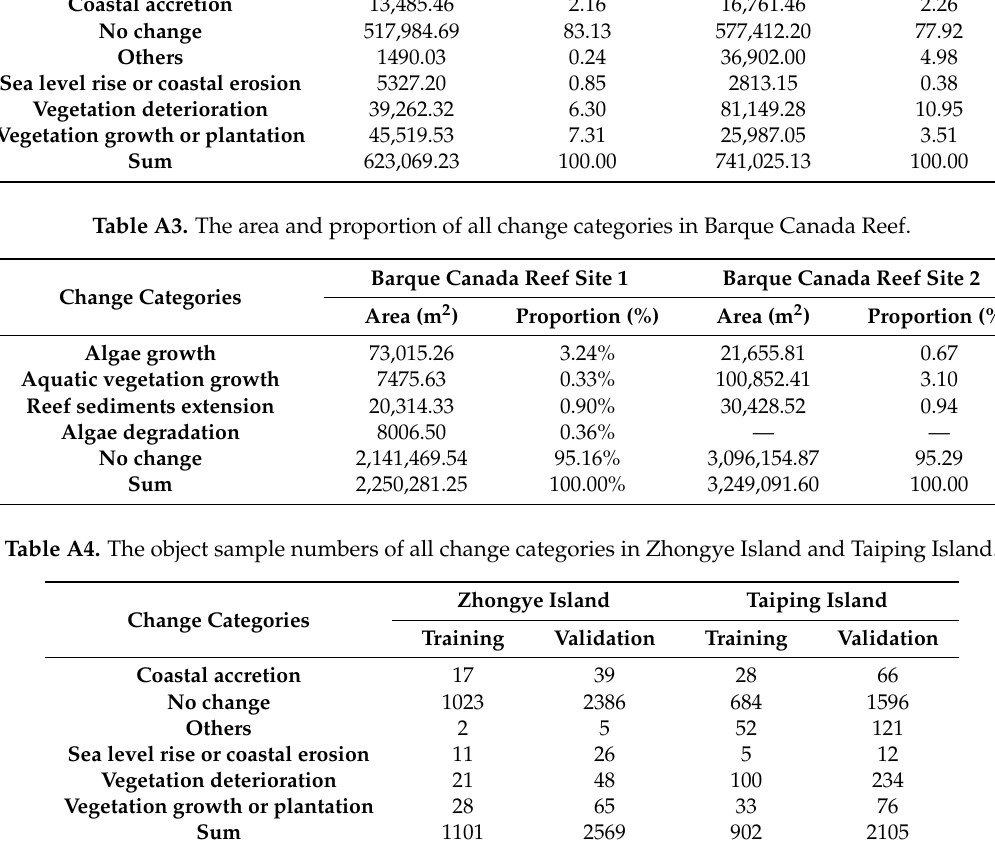
Table A2. The area and proportion of all change categories in Zhongye Island and Taiping Island. Change Categories